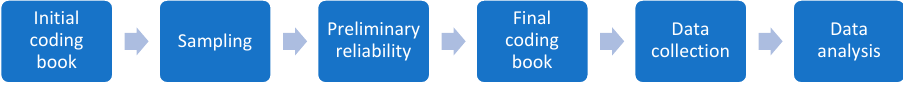
Figure 1. Research Figure 1. Research design.